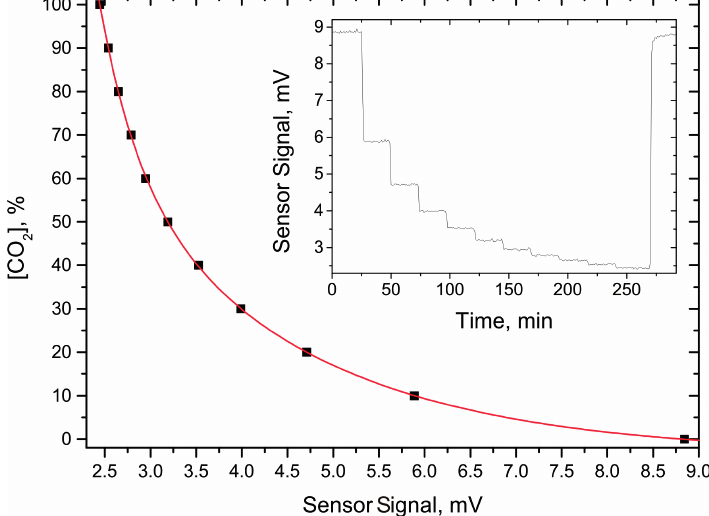
Figure 5. Concentration dependent measurement for the CO 2 absorption-QEPAS sensor. The dots represent the averaged sensor signal at each gas concentration; the red line shows an exponential fit to these values. The inset depicts the time dependent raw